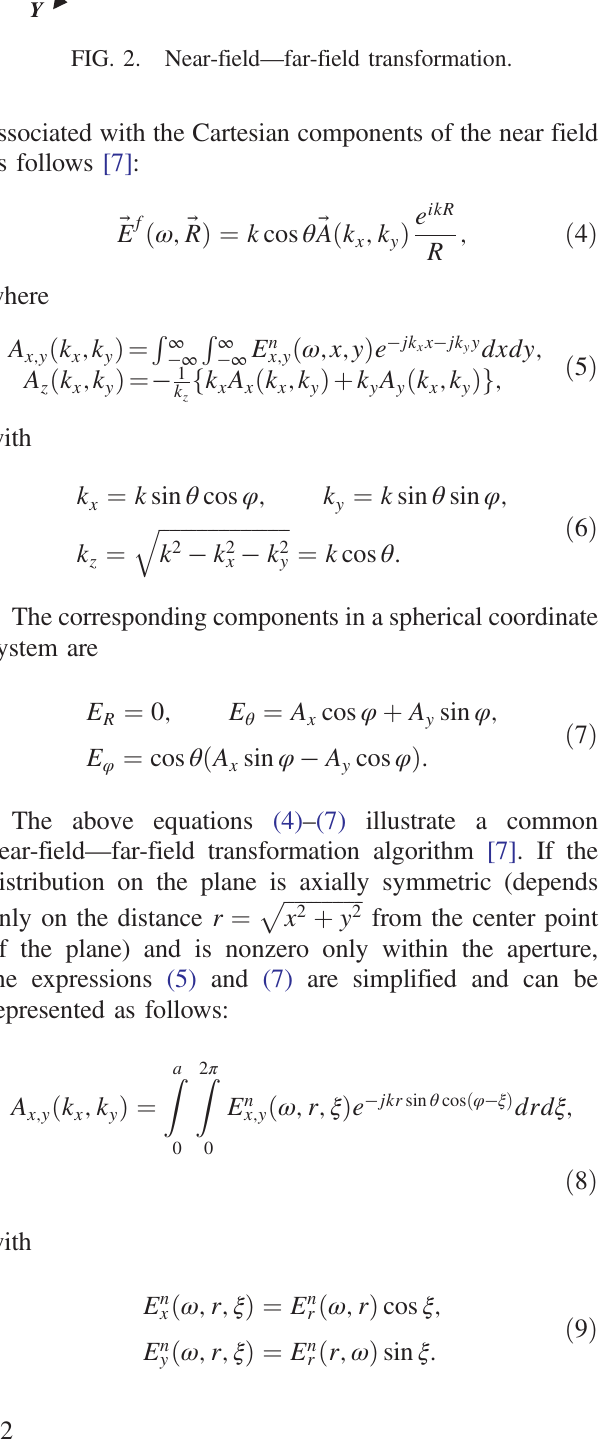
FIG. 1. Geometry of the problem.